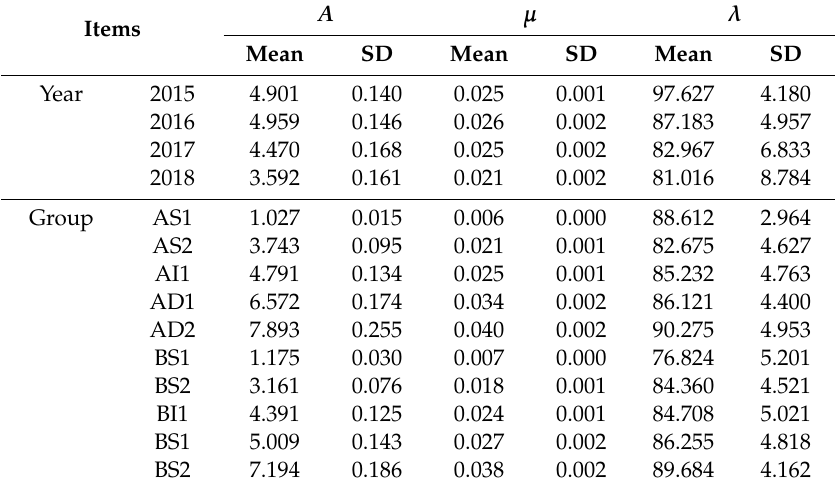
Table 2. Mean and standard deviation (SD) of radial growth and shape parameters for the radial growth of Chinese